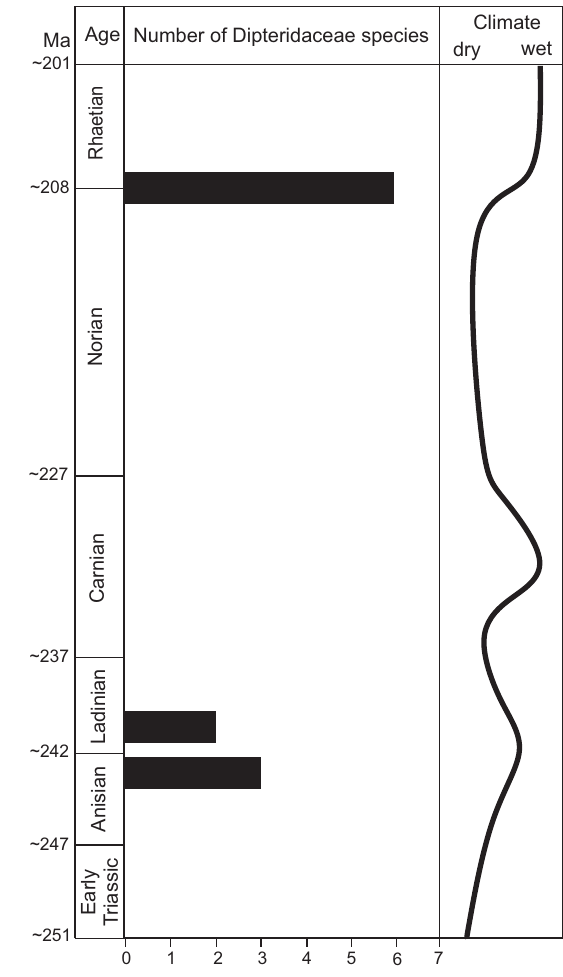
Fig. 8. Distribution of the dipterid ferns along the Triassic of Argentina, and their correlation with the inferred